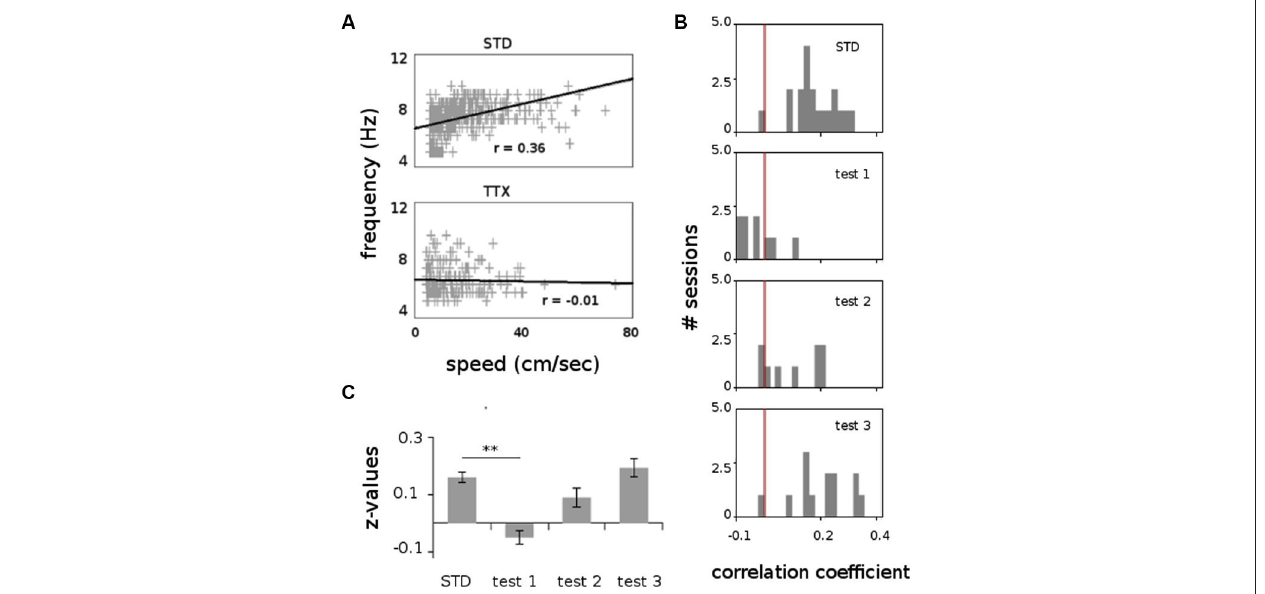
areindicated. (B) Frequencydistributionsforthecorrelationvaluesforall sessionsrecordedbeforeandafterTTXinjections.Theredbarrepresentsthe value r =0. (C) Averagevaluesofthecorrelationcoefficient(Fisher z -transformation)betweenspeedlocomotionandthetafrequency.** p < 0.01,